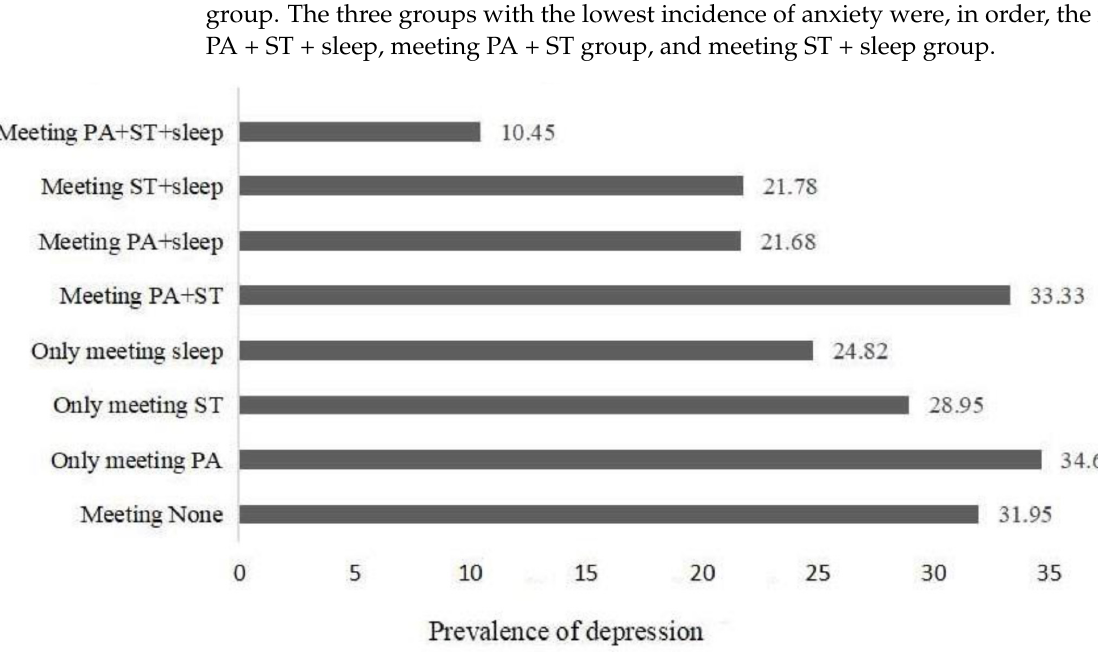
Figure 1. Prevalence of anxiety in different groups of adolescents.